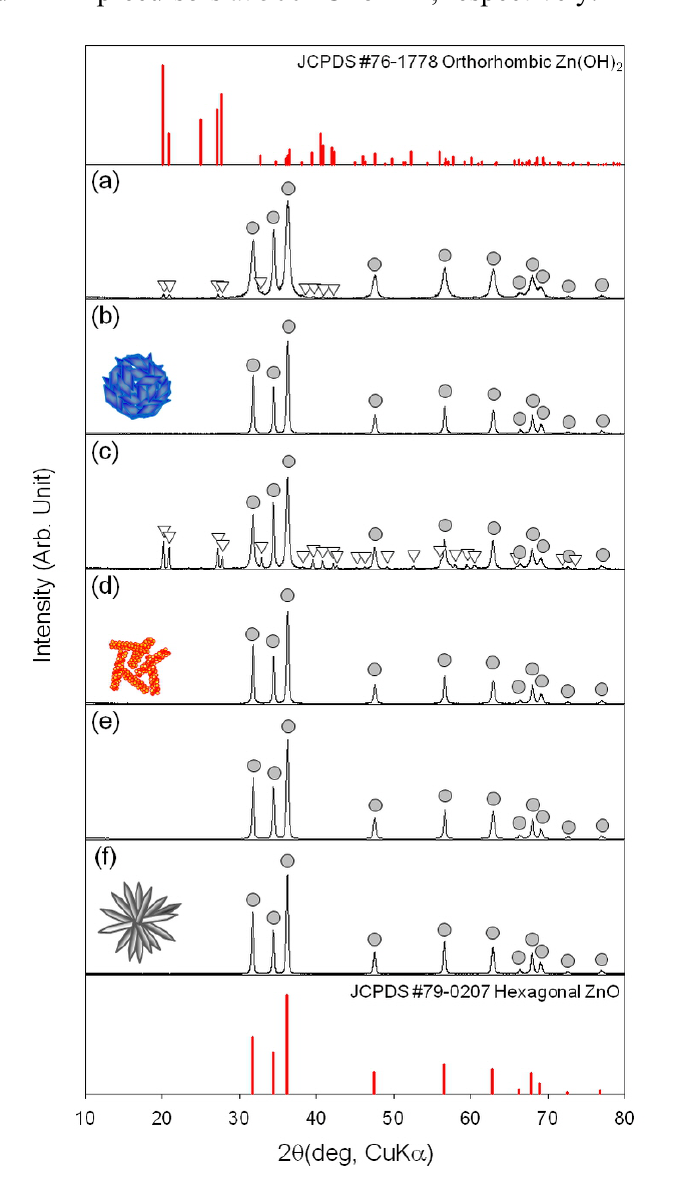
Figure 1. X-ray diffraction patterns of ( a ) H-NS precursors; ( b ) H-NS